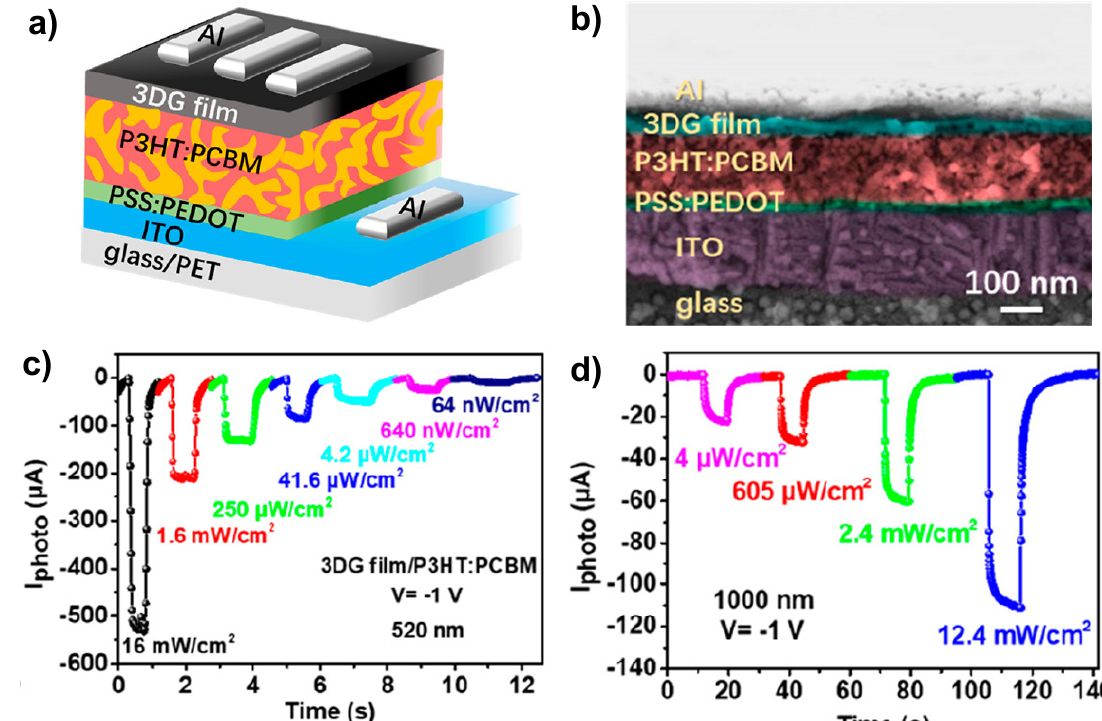
Figure 20. ( a ) Schematic of the 3DG film/organic photodetector; ( b ) Cross-sectional SEM image of the 3DG film/organic photodetector; and temporal photoresponse curves of the 3DG film/organic photodetector under 520 nm ( c ) and 1000 nm ( d ) illumination with different light intensities at − 1 V. Reprinted with permission from ref. [88]. Copyright 2022 American Chemical Society.